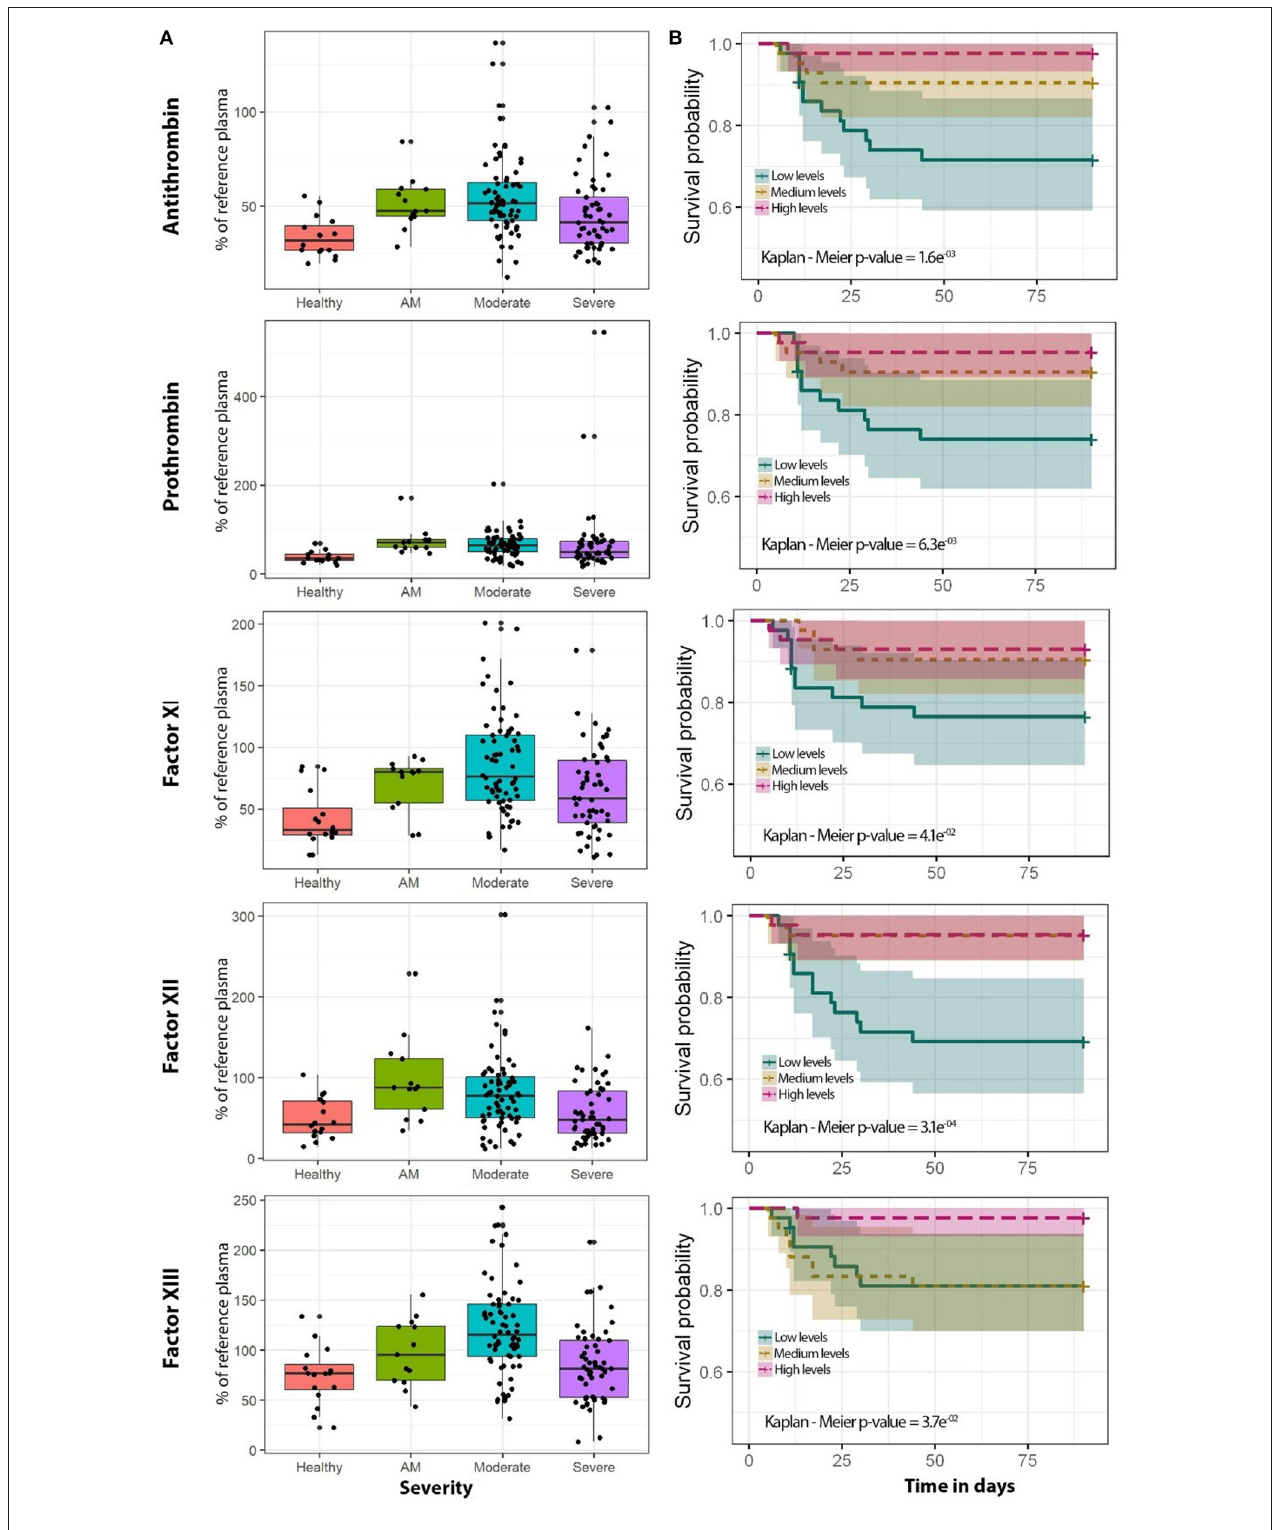
FIGURE 2 | Coagulation protein levels regarding COVID-19 severity and survival analysis for each of the coagulation proteins analyzed in this study. (A) Boxplots of healthy (purple, n = 16), AM (blue, n = 13), moderate (green, n = 68), and severe (yellow, n = 47)